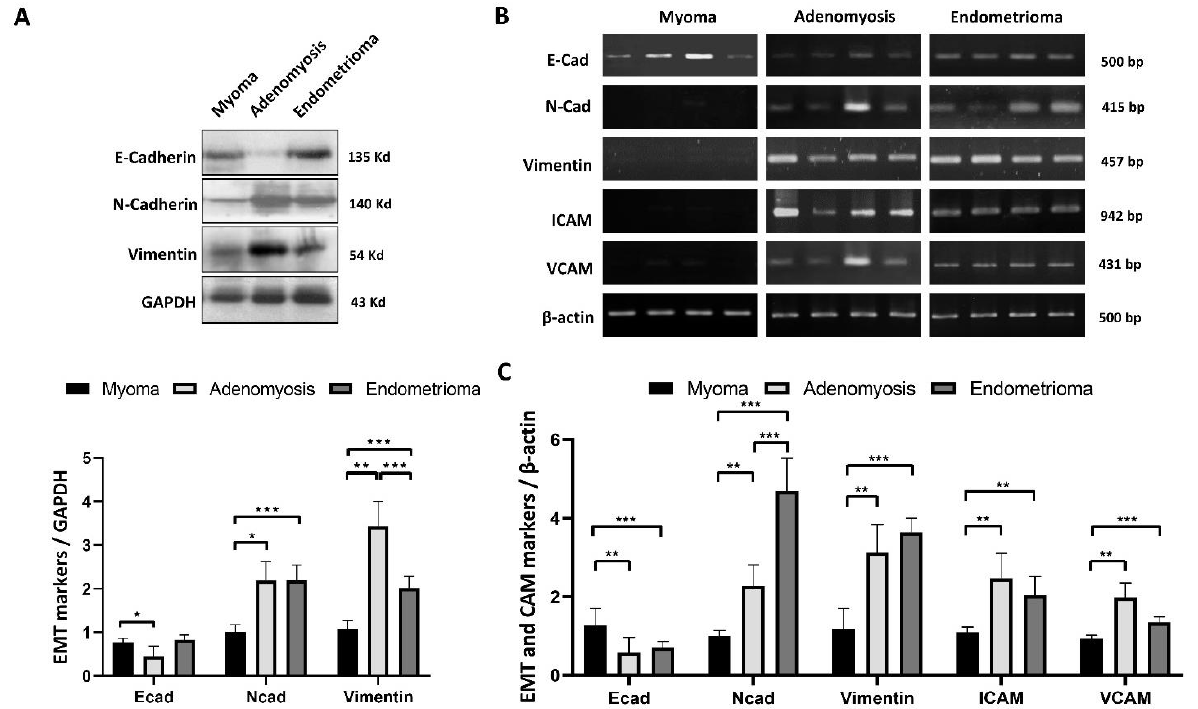
Figure 3. EMT markers and cell adhesion molecules (CAM) in myoma, adenomyosis and ectopic endometriosis lesions. ( A ) Representative chemiluminescence image of Western blot data demonstrated increased EMT markers in endometriosis. E-cadherin was underexpressed in adenomyotic lesions. N-cadherin and Vimentin were both found to be overexpressed in myoma tissue and endometriotic lesions. Additionally, the Vimentin concentration was extremely high in adenomyosis compared with endometrioma, myoma, and normal endometrium ( p < 0.05). ( B ) The mRNA expression levels of EMT markers, including N-cadherin, E-cadherin, Vimentin, and CAM markers, ICAM and VCAM, were detected by quantitative real-time PCR, as shown in the electrophoretogram. ( C ) Analysis and normalization of the mRNA levels of EMT and CAM markers. E-cadherin was down- regulated, while N-cadherin, Vimentin, ICAM and VCAM expression was upregulated in endome- triotic lesions ( p < 0.05). Plots represent the mean ± SEM. Ecad: E-cadherin; Ncad: N-cadherin; ICAM: intercellular adhesion molecule; VCAM: vascular cell adhesion molecule. ( * ) indicates a significant difference with p < 0.05. ( ** ) indicates a significant difference with p < 0.01. ( *** ) indicates a significant difference with p < 0.001.